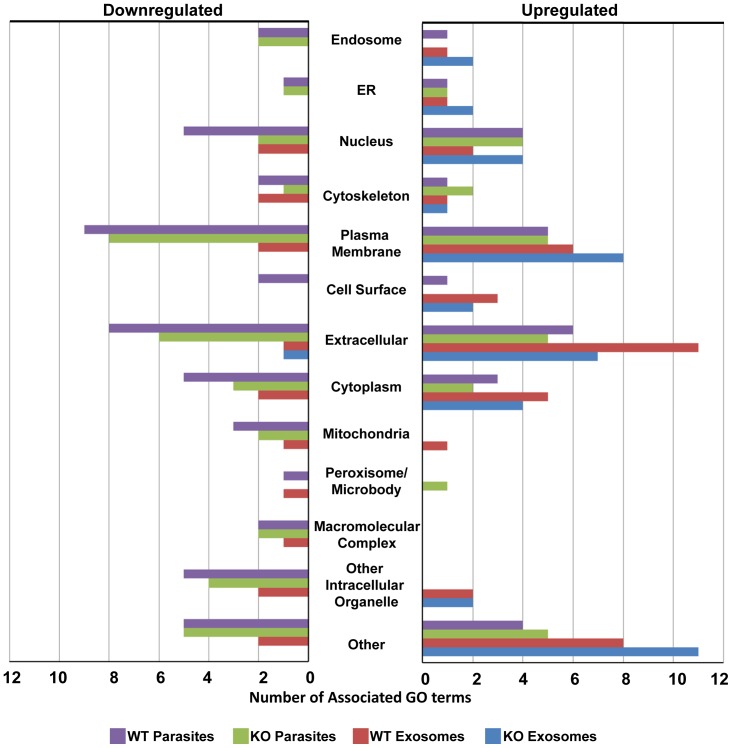
Gene ontology analyses of upregulated and downregulated genes.WT parasites, and to some extent KO parasites strongly downregulate expression of many immune-related genes, especially with plasma membrane, extracellular associated and nucleus GO terms, indicating secretory factors, receptors and transcription regulation proteins. Although WT exosomes do inhibit expression of certain genes, exosomes in general have a more stimulatory nature.